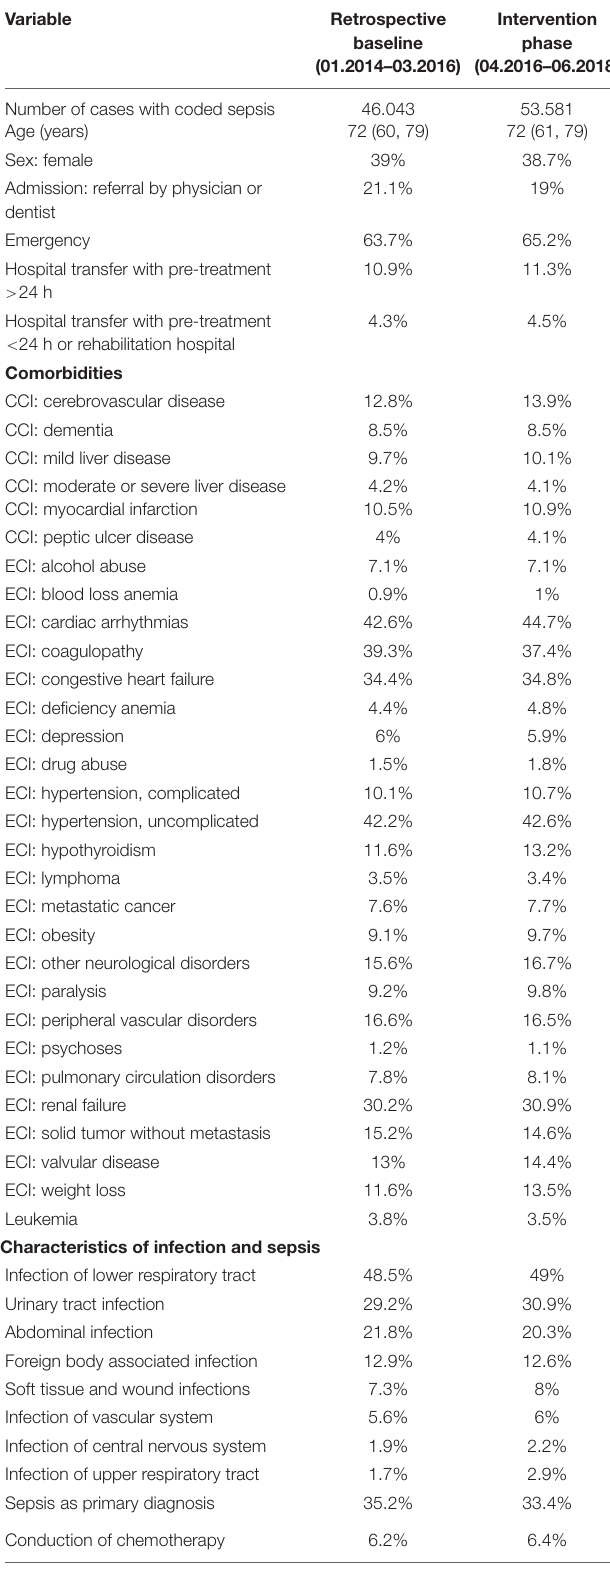
TABLE 1 | Characteristics of included cases with coded